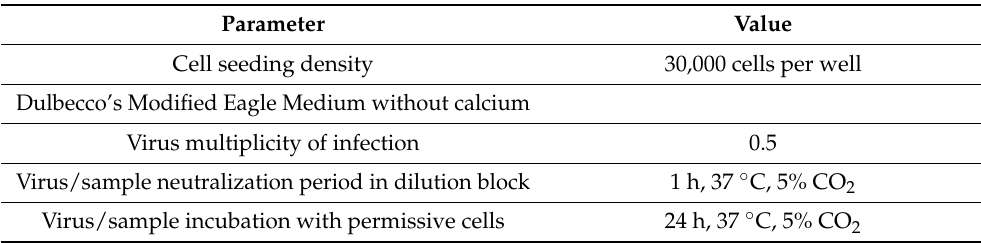
Table 1. Assay setup